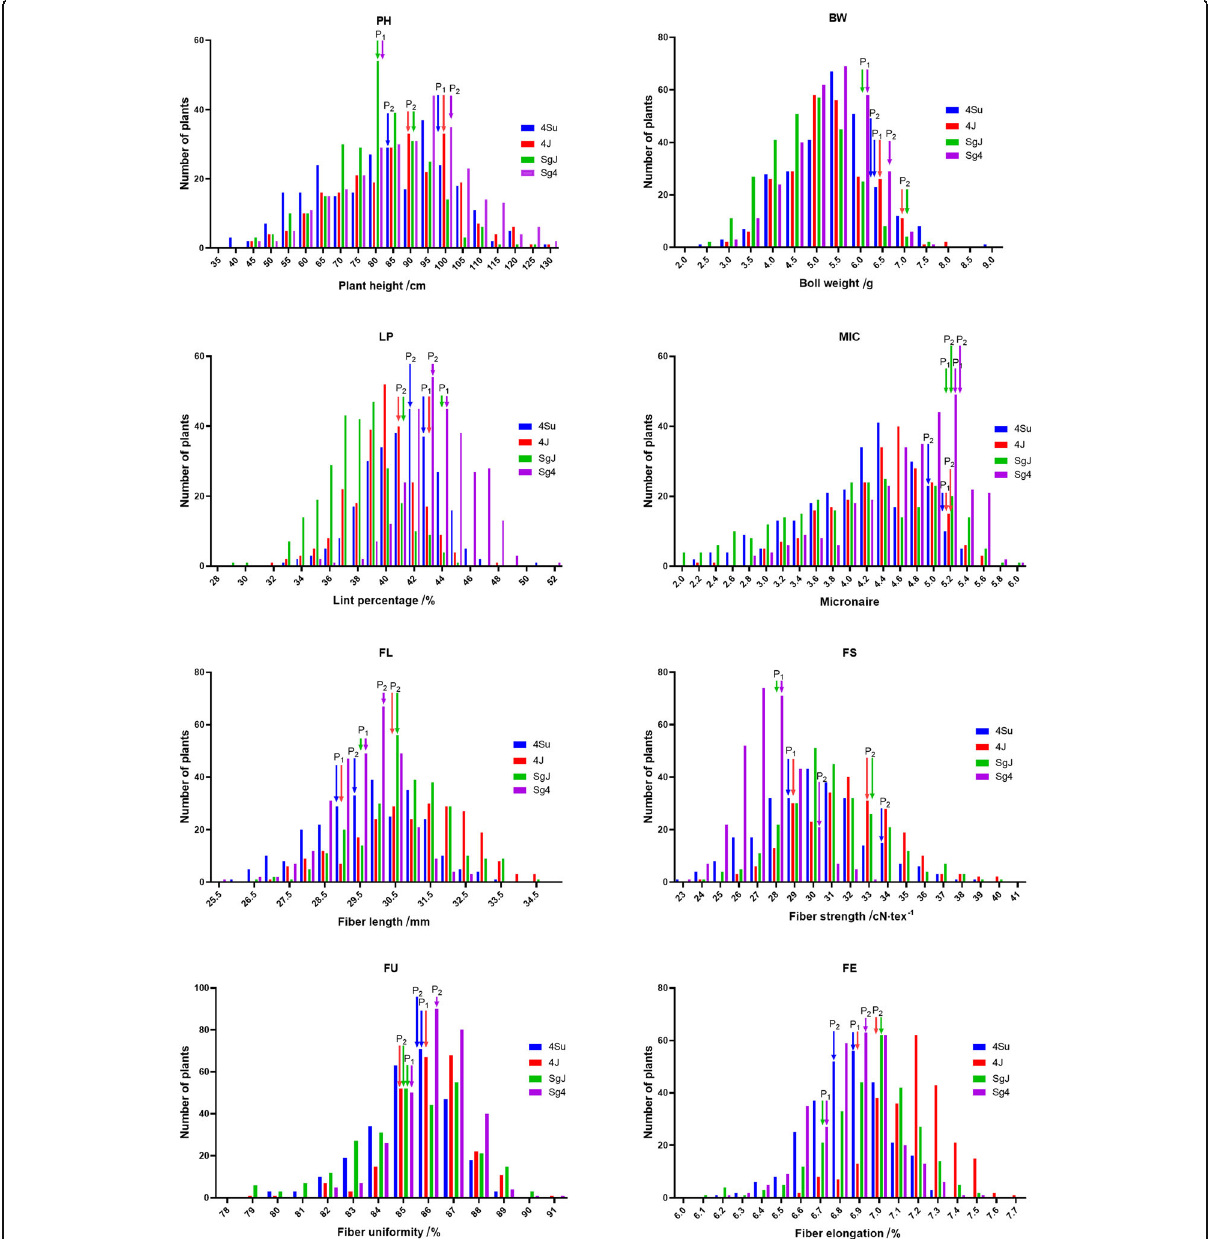
Fig. 1 Histogram of the frequency distribution for 8 traits across 4 populations. Plant height (PH), boll weight (BW), lint percentage (LP), fiber length (FL), fiber strength (FS), fiber length uniformity (FU), micronaire (MIC), fiber elongation